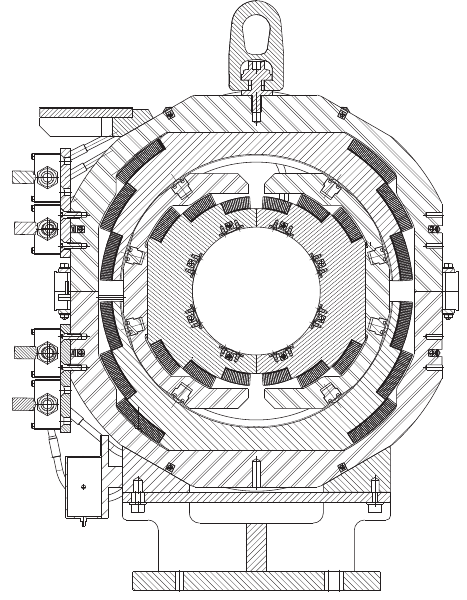
FIG. 16. Cross section of H = V corrector magnet. The inner aperture has a diameter of 124 mm.